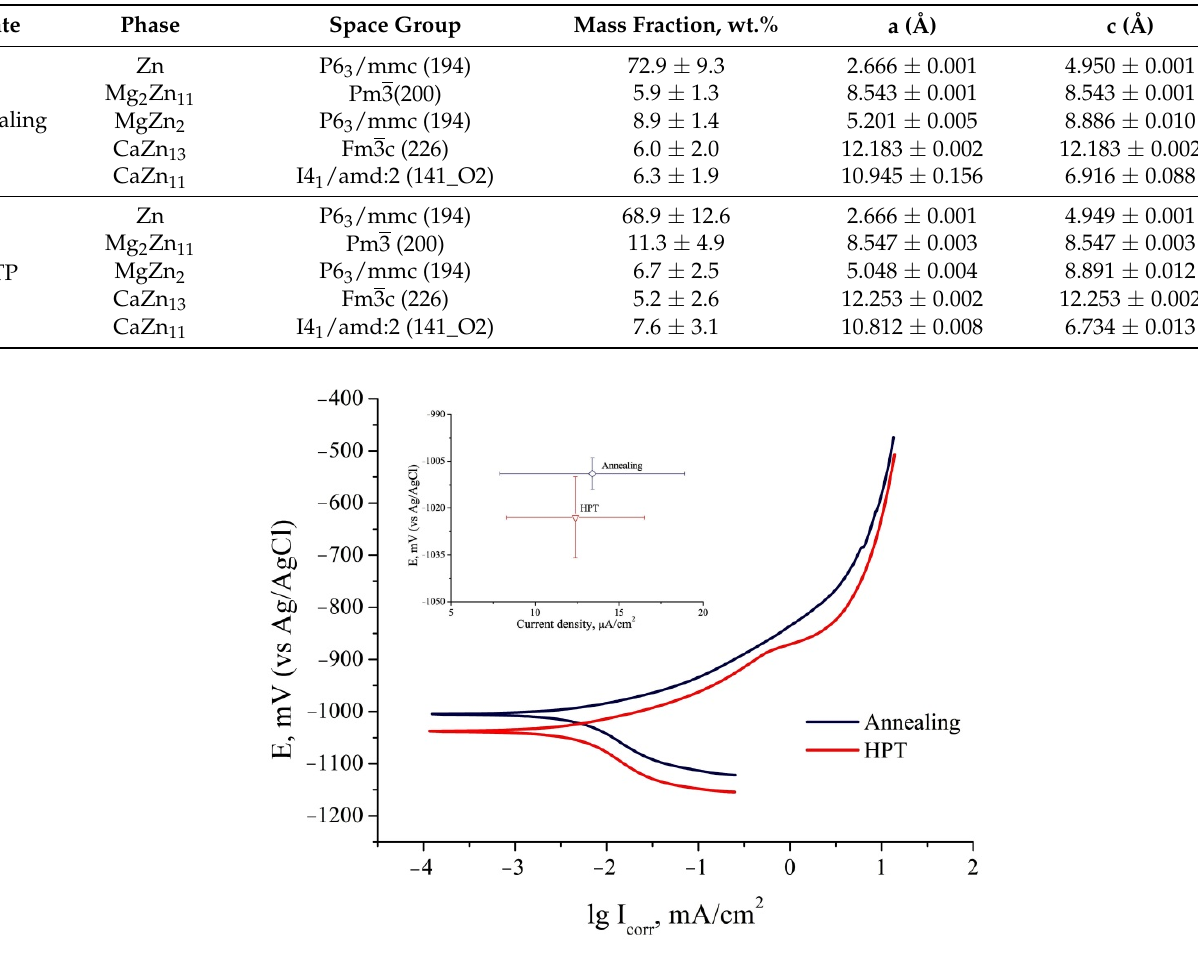
Figure 4. Polarization curves (Ag/AgCl electrode) in 0.9% NaCl solution and the values of the corrosion potential and the current density for the specimens with different processing histories.